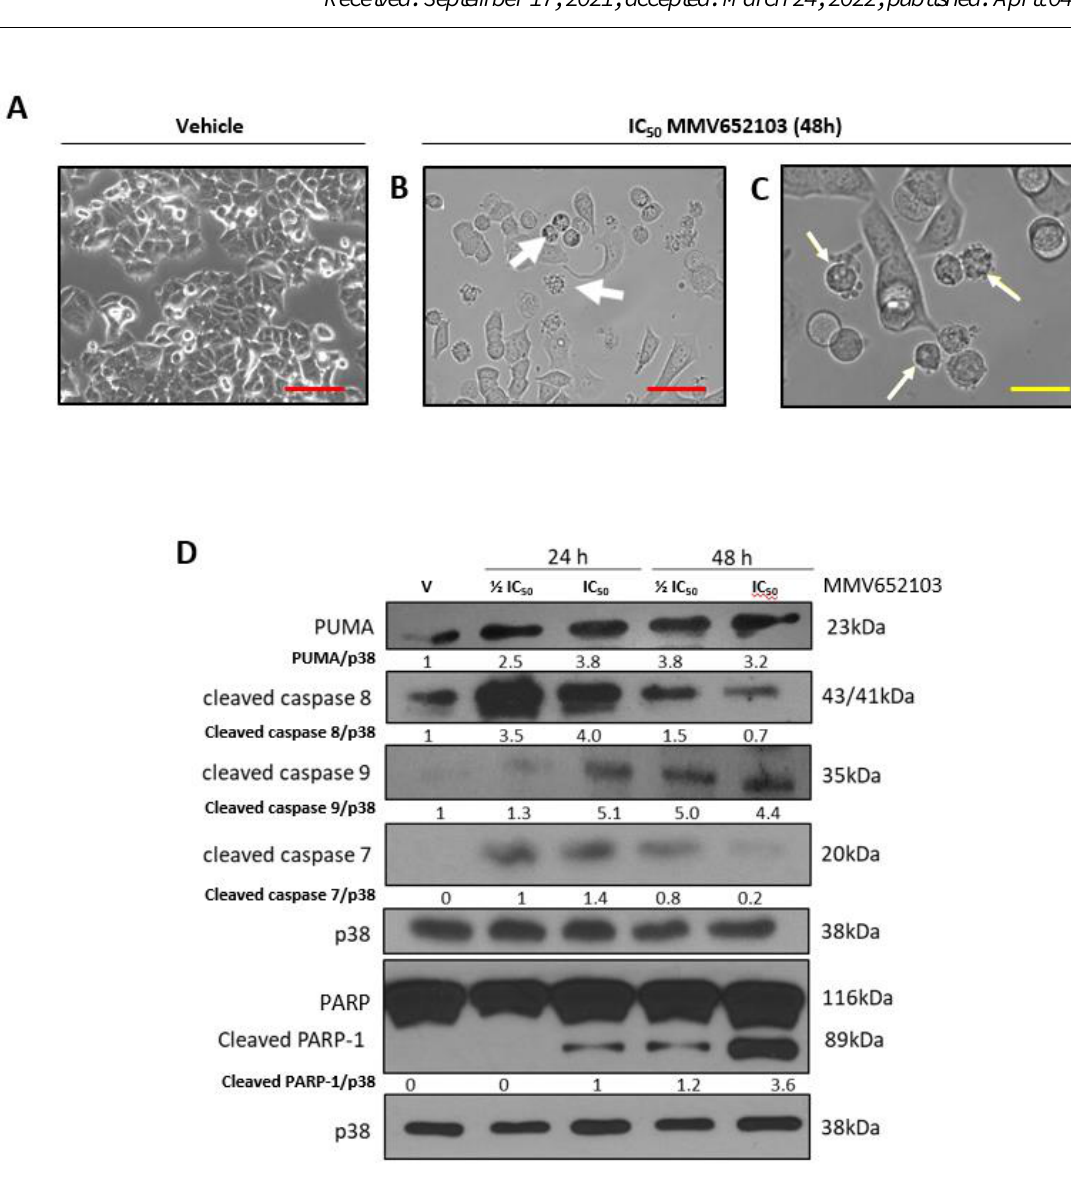
Figure 6: MMV652103 induces apoptosis. Representative phase-contrast photomicrographs are shown of MCF7 cells treated with ( A ) vehicle (DMSO) and ( B and C ) IC 50 MMV652103 for 48 h (EVOS XL AMEX1000 Core Imaging System; red scale bar = 100 µm (100X), yellow scale bar = 25 µm (200X)). White arrows indicate morphological features of apoptosis including cell shrinkage, membrane blebbing and pyknosis. ( D ) Western blotting of protein from MCF7 cells treated with ½ IC 50 and IC 50 concentra- tions MMV652103 and antibodies to key apoptotic markers as indicated. Total p38 was used as a load- ing control. Densitometry readings were obtained using ImageJ and protein expression levels are rep- resented as a ratio of protein of interest/p38 normalized to the vehicle control sample. Blots are repre- sentative of at least three independent